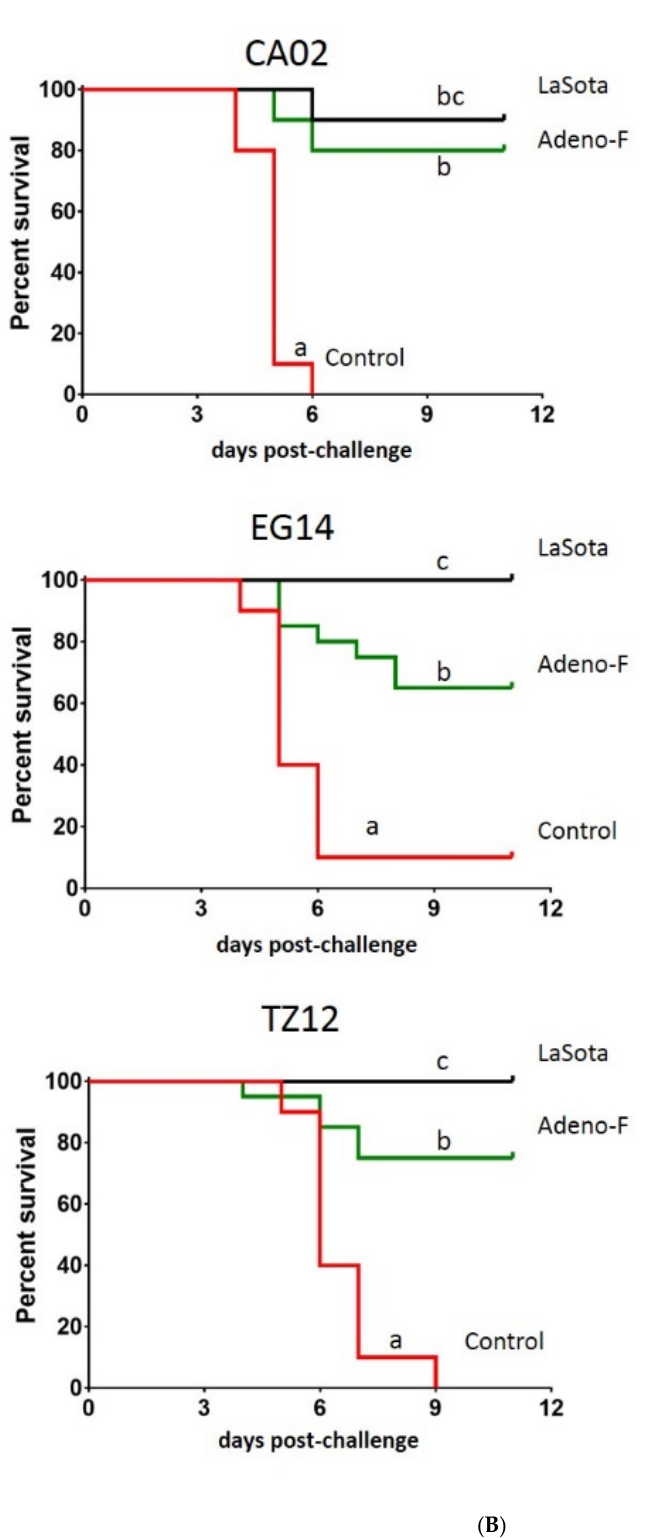
Figure 2. Survival rates after Newcastle disease virus (NDV) challenge in control and vaccinated birds. ( A ) Vaccinated birds with the low and high doses of adeno-F and control groups were monitored after NDV challenge with CA02 virus for 14 days. ( B ) Birds vaccinated with adeno-F and LaSota virus and non-vaccinated birds (control) after NDV challenge with CA02, EG14, and TZ12 viruses for 11 days. Different letters are statistically significant ( p < 0.05).